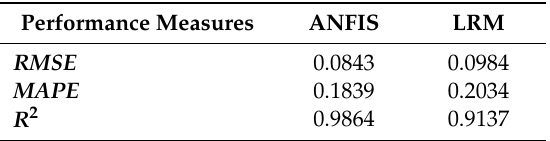
Table 11. Comparisons between the accuracy of ANFIS and Linear Regression Method